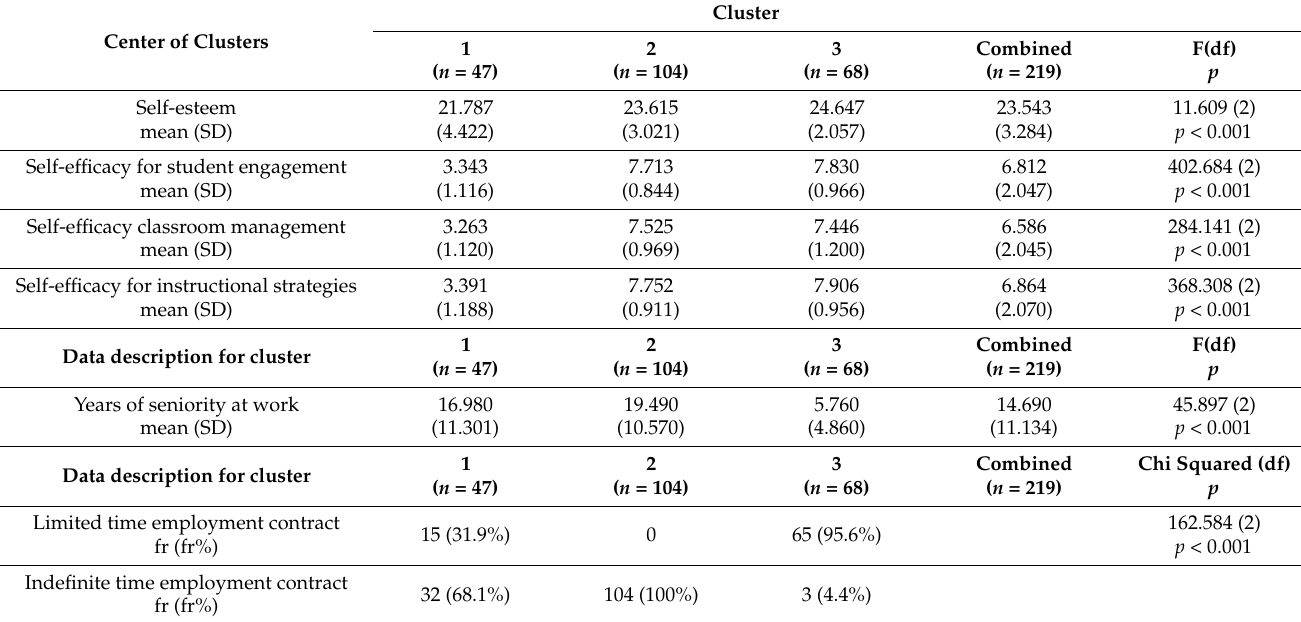
Table 7. Description of the three clusters according to the variables